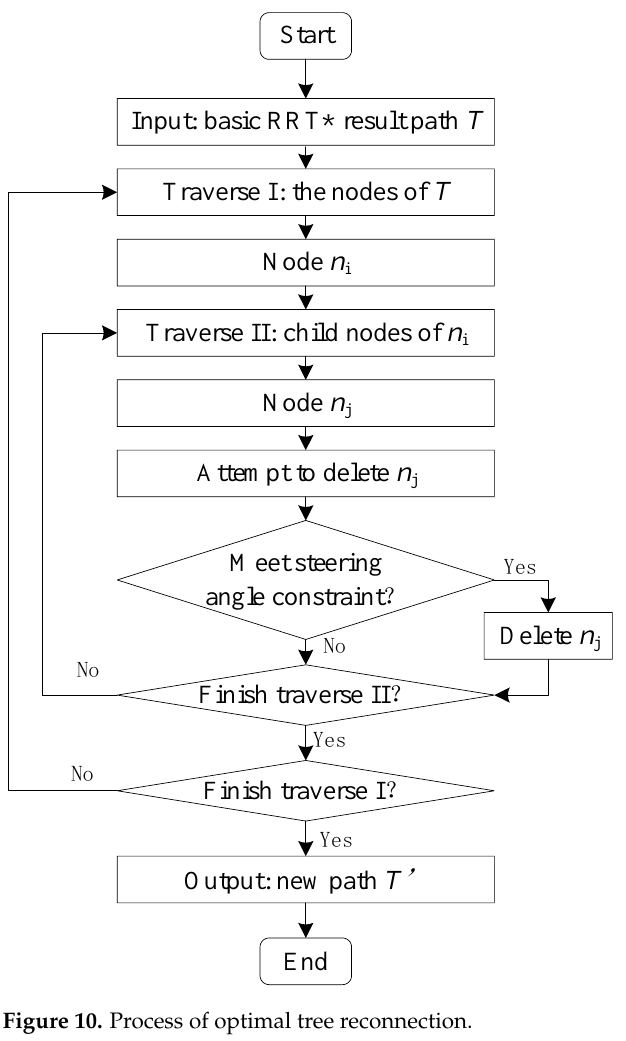
Figure 10. Process of optimal tree reconnection.